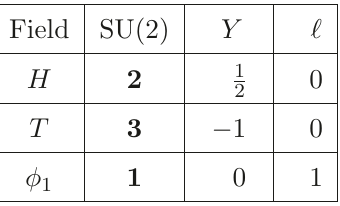
Table 2 . Scalar fields